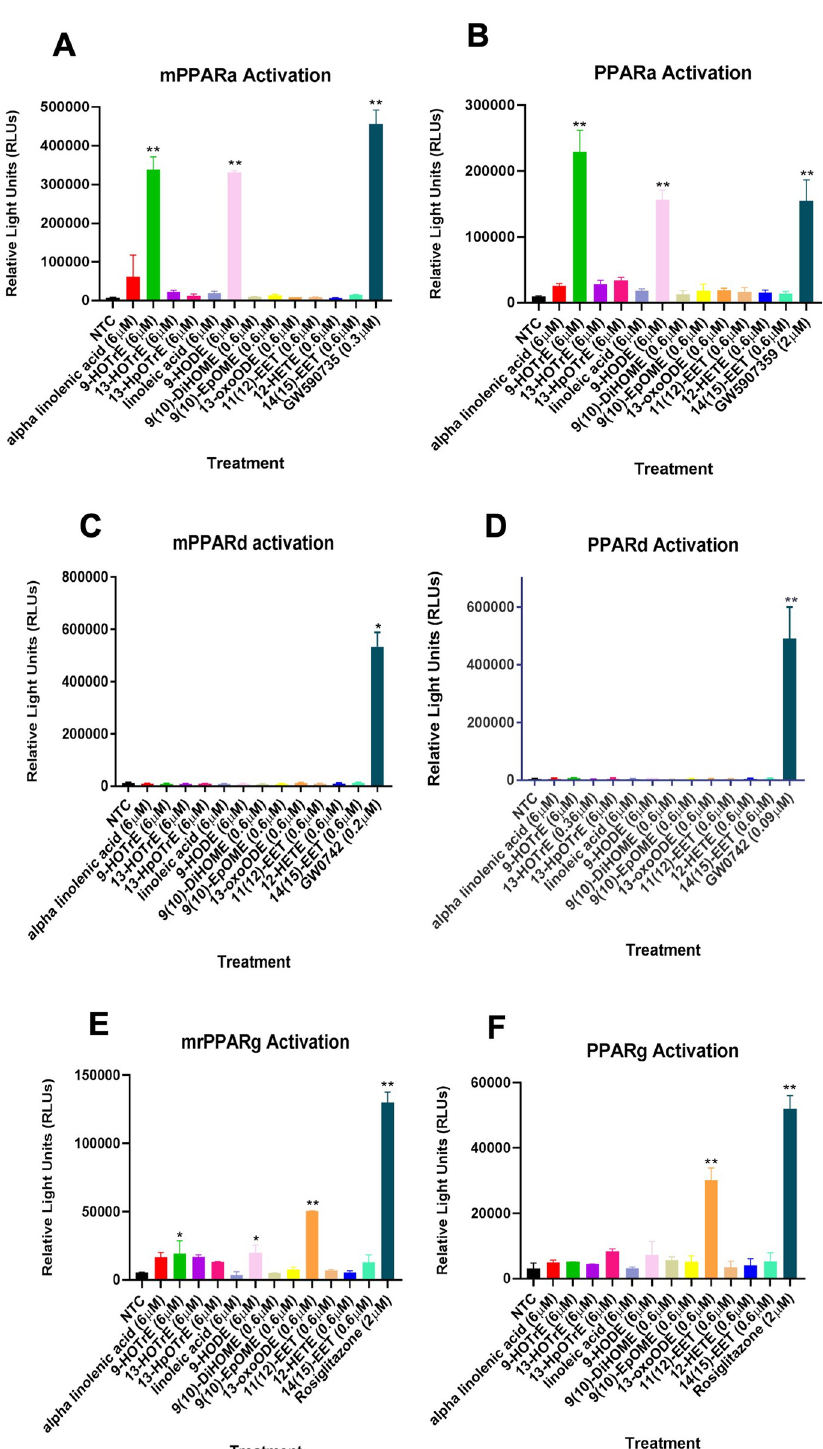
Fig 8. Transactivation assays reveal some CYP2B6-produced oxylipins activate PPARs. Mouse and human (A/B) PPAR α , (C/D) PPAR δ , and (E/F) PPAR γ are activated by oxylipins primarily oxidized in the 9 and 13 positions. Data are presented as mean ± SEM. Statistical significance was determined by unpaired Student’s t-tests (n = 2–3). � indicates a p-value < 0.05 and �� indicates a p-value < 0.01.